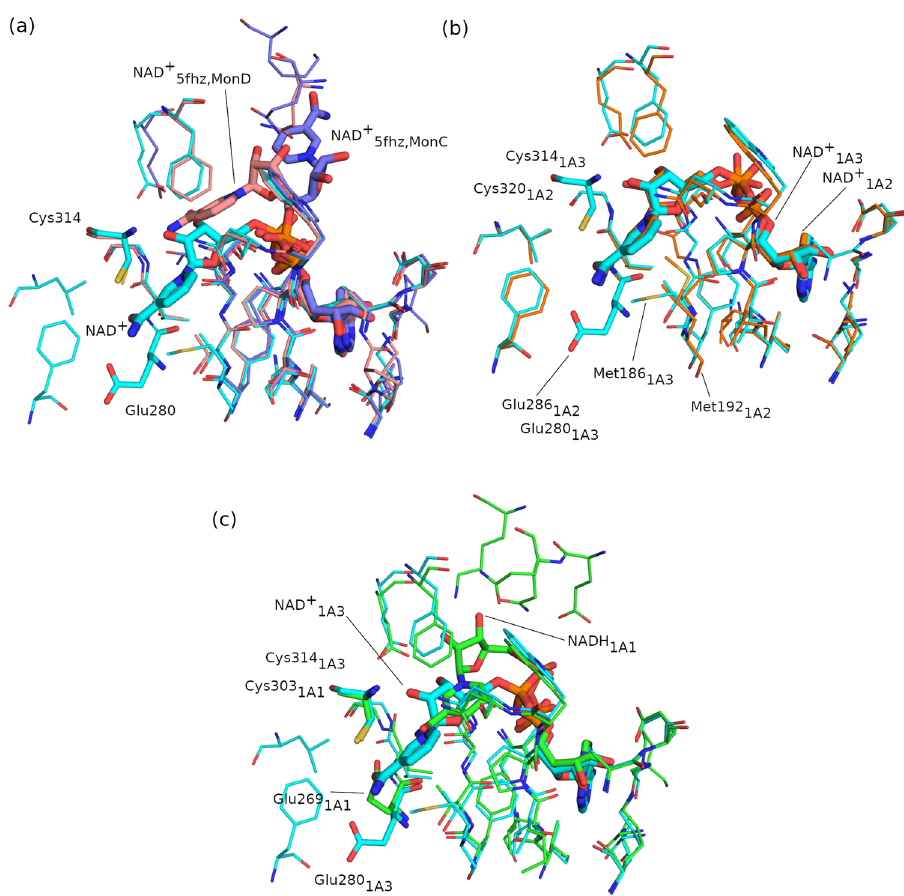
Fig. 4 Structural alignment of present ALDH1A3-NAD + structure with those of ALDH1A3, ALDH1A2, and ALDH1A1. a Alignment of current ALDH1A3- NAD + (in cyan) with monomers C (in pink) and D (in purple) of the PDB 5FHZ structure (ALDH1A3 complexed with NAD + and retinoic acid). b Alignment between ALDH1A3-NAD + (in cyan) and PDB 6B5G structure (ALDH1A2 with NAD + and 3-ethoxythiophen-2-yl){4-[4-nitro-3-(pyrrolidin-1-yl)phenyl] piperazin-1-yl}methanone, in orange). The conformation of all conserved residues remains unchanged except for the catalytic Cys320/Cys314 and the non-catalytic Met192/Met186 residues. c Alignment between the ALDH1A3-NAD + (in cyan) complex and PDB 4WB9 structure (ALDH1A1 complexed with NADH, in green). Cofactor molecules and catalytic Cys and Glu residues are depicted with sticks while other residues interacting with the cofactor are shown with thin lines. Table 2 Inhibition of ALDH activity in the presence of 2 mM ATP.